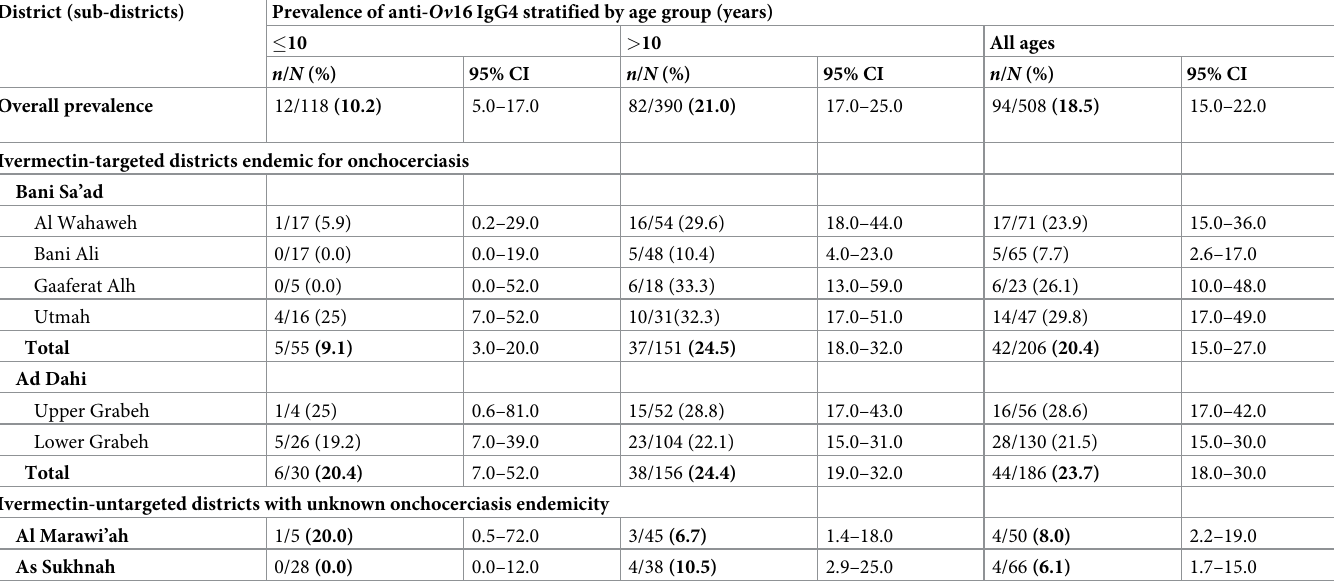
Table 2. Age-stratified prevalence and distribution of anti- Ov 16IgG4 in Hodeidah and Al-Mahwit governorates of Tihama region, Yemen (2017). District (sub-districts) Prevalence of anti- Ov 16 IgG4 stratified by age group